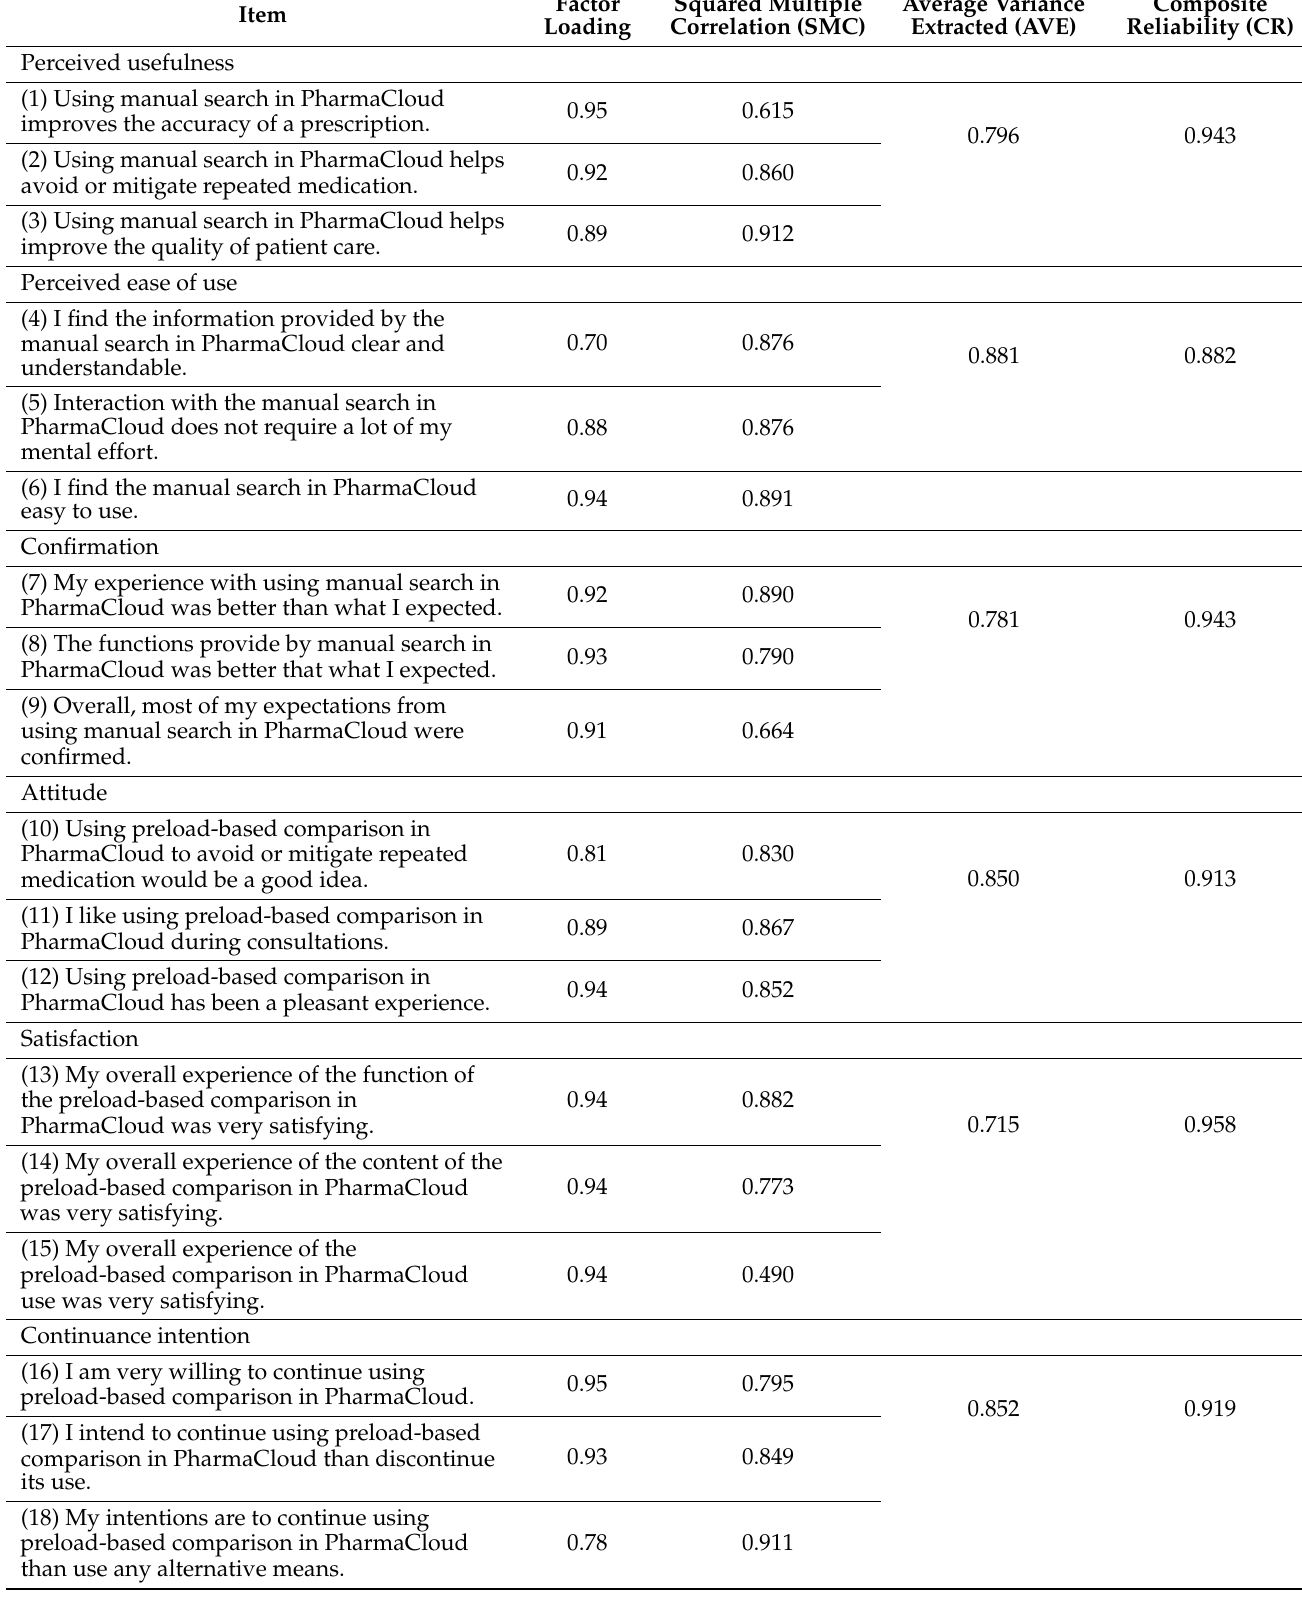
Table 4. Confirmatory factor analysis results for manual